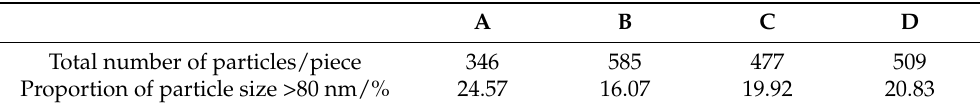
Table 4. Size statistics of precipitates in the